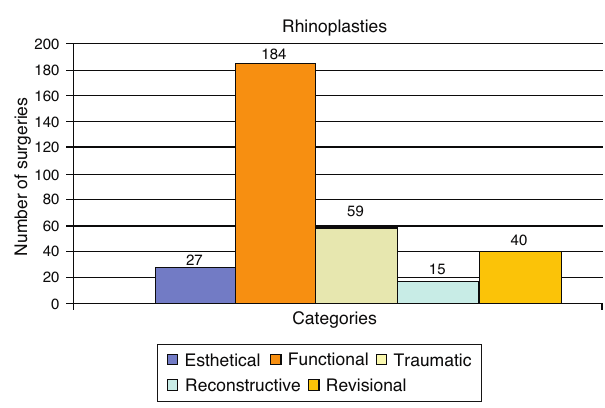
RevisionalFunctional Traumatic Esthetical Reconstructive Functional, esthetic, post-traumatic, reconstruc- tive, and revision rhinoseptoplasties performed from January of 2003 to August of 2012.